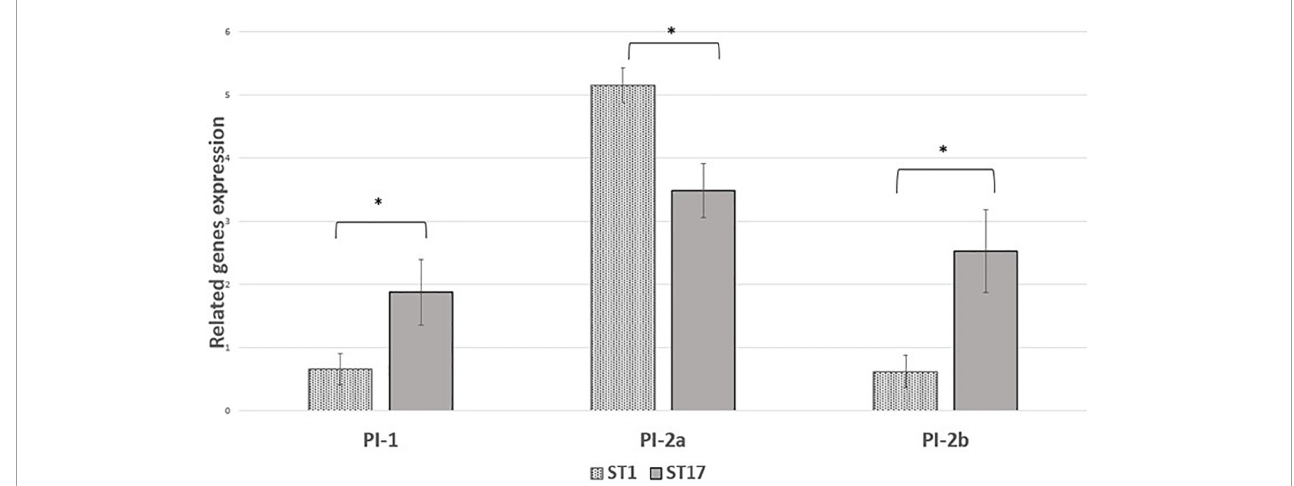
FIGURE6 The expression of pili islands gene expression in ST17 and ST1 group B streptococcus (GBS) strains from Mayanei Hayeshua Medical Center (MHMC) were analyzed by qRT-PCR analysis. Amounts of each transcript are normalized to rpoB gene and expressed relative to this gene in reference strain ATCC BAA611. The expression level of ATCC BAA611 strain was defined as 1. Columns represent relative mRNA expression level of each gene from each strain. Values are represented as means ± SD ( n = 8) from three independent qRT-PCR experiments. Error bar show SD. Asterisk indicates a significant difference ( ∗ p < 0.05 by t -test).